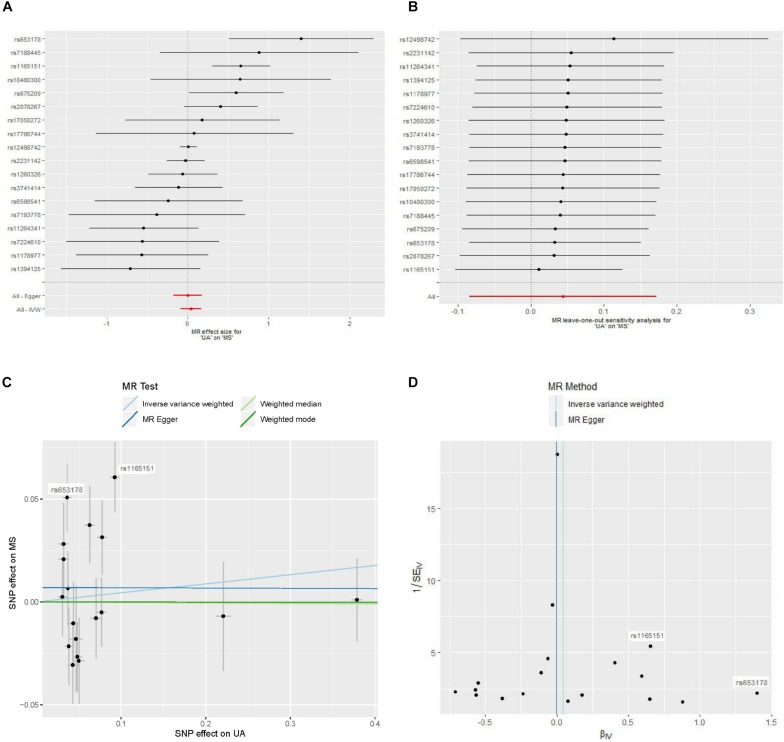
Forest plot, leave-one-out sensitivity analysis, scatter plot, and funnel plot of the effect of serum uric acid level on multiple sclerosis. Abbreviations: MR = Mendelian randomization; MS = multiple sclerosis; SNP = single-nucleotide polymorphism; UA = uric acid; IVW = inverse variance weighted. (A) Forest plot: The horizontal axis represents the estimate of serum UA level (log odds per 1-mg/dl increase) on MS. (B) Leave-one-out sensitivity analysis: Each black point represents the estimate of serum UA level (log odds per 1-mg/dl increase) on MS after the corresponding SNP was excluded. (C) Scatter plot: Each black point represents a SNP, plotted by the estimate of SNP on serum UA level (x-axis, 1-mg/dl units) and the estimate of SNP on the risk of MS (y-axis, log odds ratio) with standard error bars. The slopes of the lines correspond to causal estimates using each of the four different methods. (D) Funnel plot: Each black point represents a SNP, plotted by the estimate of serum UA level on the risk of MS on the horizontal axis and the inverse of the standard error of the estimate on the vertical axis. The vertical lines show the pooled estimates using two MR methods.